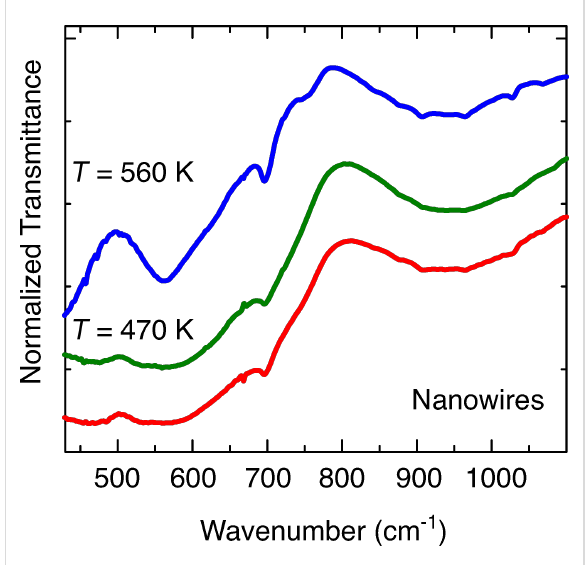
Figure 2: Infrared spectrum (normalized transmittance signal) of the nanowire sample (sample 2, red line), and of the specimen obtained from sample 2 after a thermal treatment at 470 K (sample 3, green line) and at 560 K (sample 4, blue line). In order to compare the trans- mission of different oxide powders, the transmittance spectra have been normalized. Data are vertically stacked, for the sake of clarity.